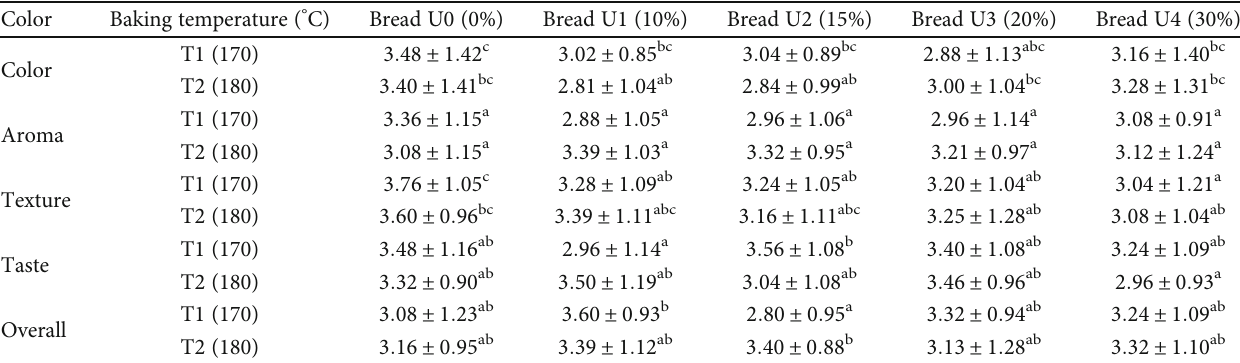
Table 3: Sensory acceptability of plain bread with di ff erent baking temperature and yam fl our